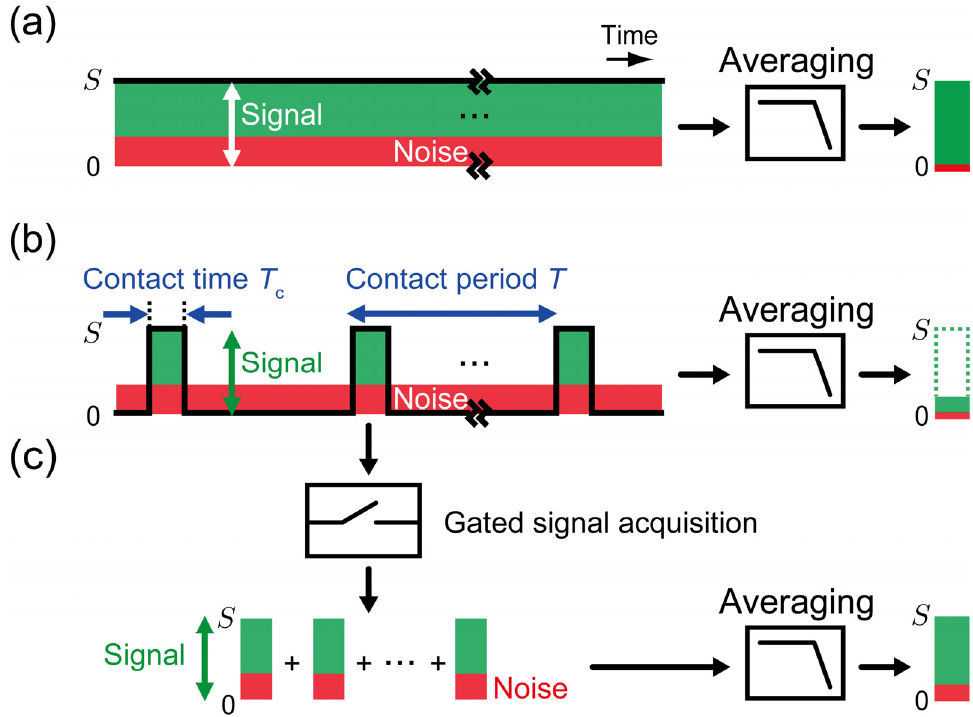
Figure 2. Schematic illustration of signal acquisition and the achievable S/N ratio in ( a ) C-SNDM, ( b ) PFT-SNDM, and ( c ) BA-PFT-SNDM. Green parts indicate the intensity of d C /d V signals, or the amplitude of frequency shift, in the capacitance sensor. Red parts depict noise levels.